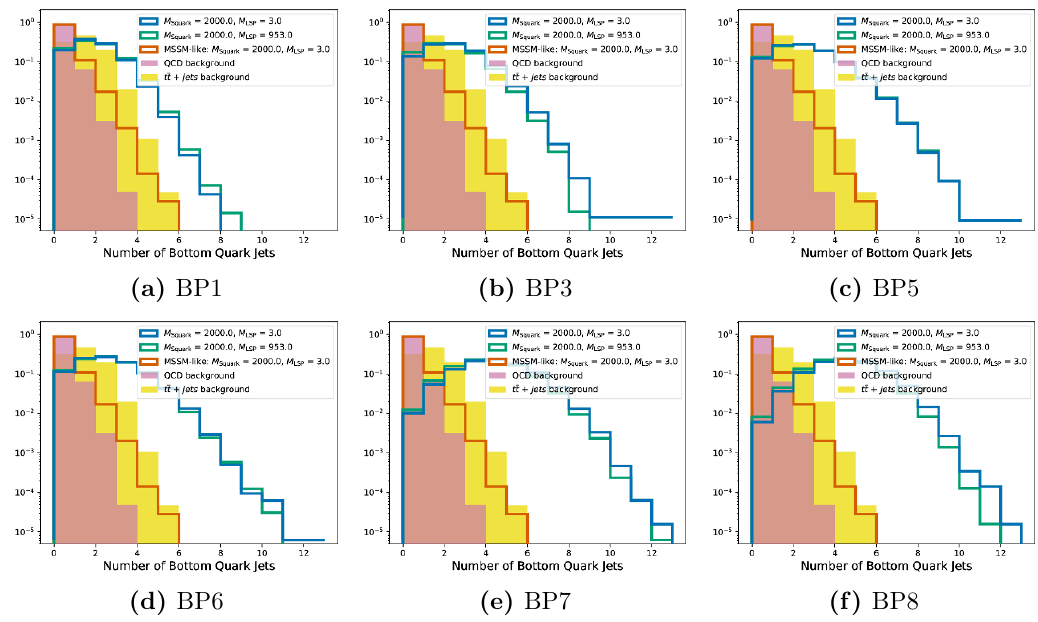
Figure 11. Number of b -tagged hadronic jets for low and mid-range M LSP near the observed limit in the BP1-type scan, compared with QCD and t (cid:22) t background processes and an MSSM-like scenario with a light